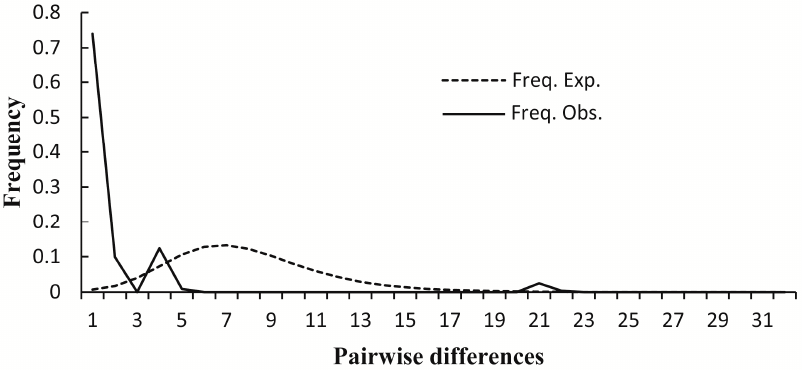
Figure 3. Mismatch distribution analysis plots for D. sinensis.